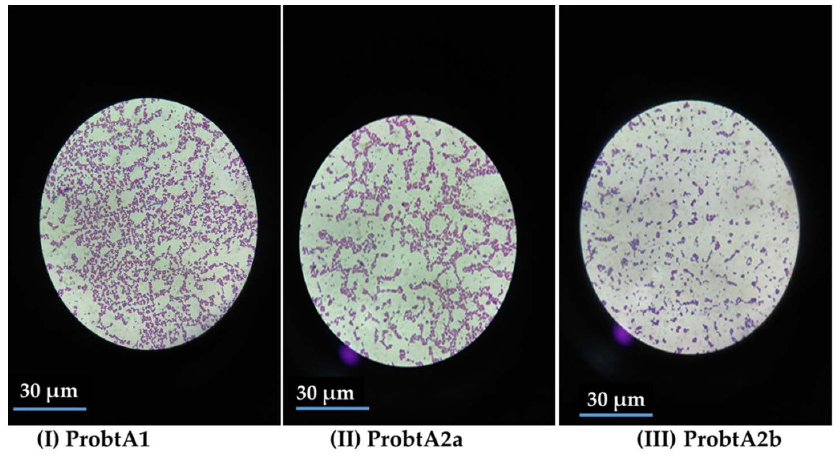
Figure 1. The microscopic view of the isolated lactic acid bacteria (LAB).